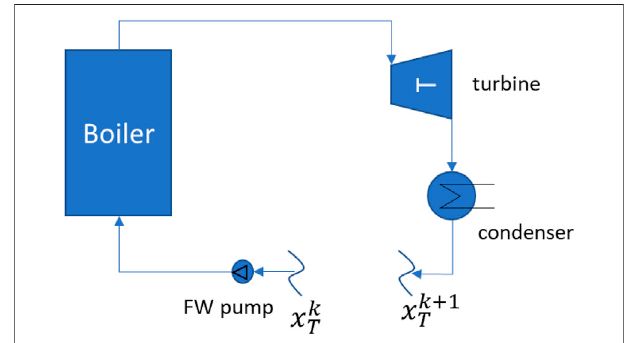
FIGURE 1 | Example of a steam cycle simulated with the sequential- modular mode using the condenser outlet fl ow as tear stream.